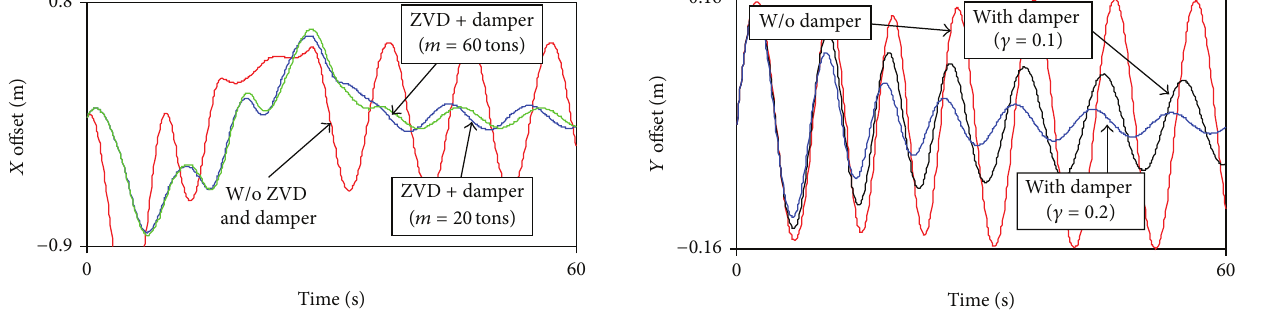
Figure 7: Effect of mass variance on the spreader 𝑋 -offset.